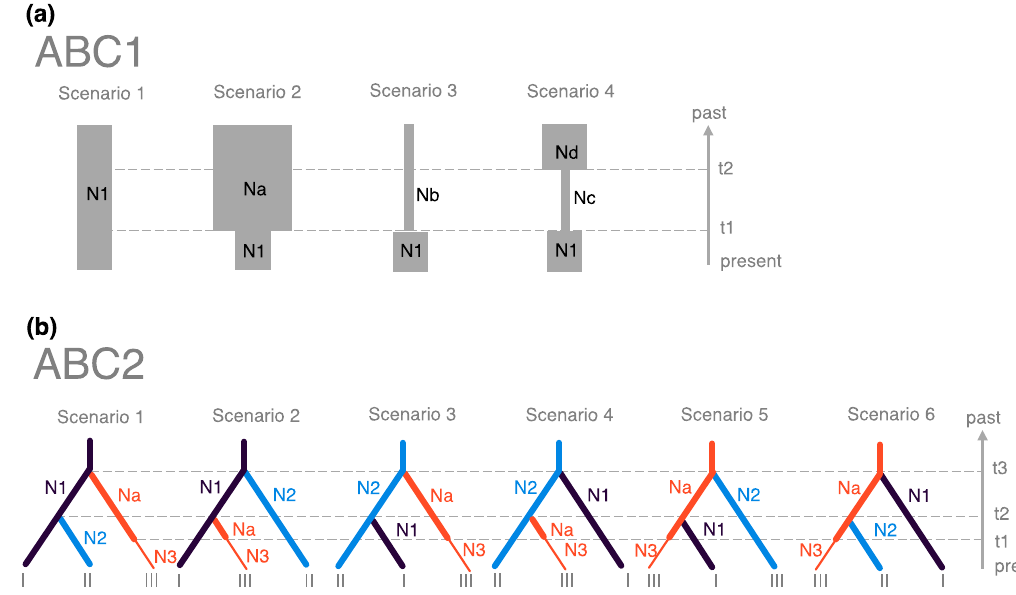
Figure 4. Scenarios tested using DIYABC in this study. ( a ) The four scenarios tested in ABC1. ( b ) The six scenarios tested in ABC2. See text for explanations. In all the scenarios, t# represents the time scale measured in number of generations, and N# represents the effective population size of the corresponding populations.